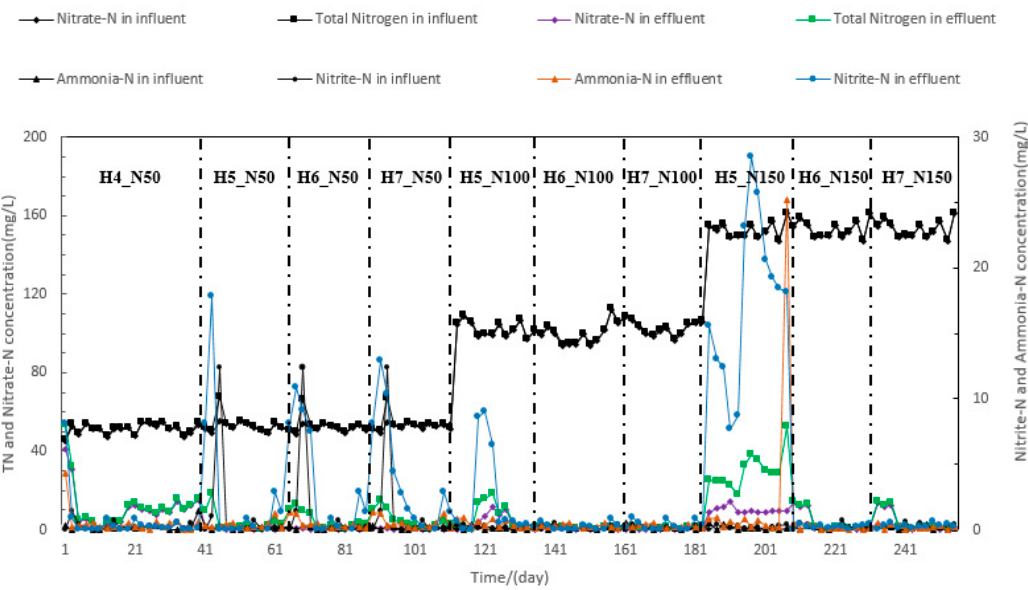
Figure 2. Long-term nitrogen removal performance of the denitrification reactor at different hydraulic retention times (H, in hours) and influent nitrate-N concentrations (N, in mg/L).